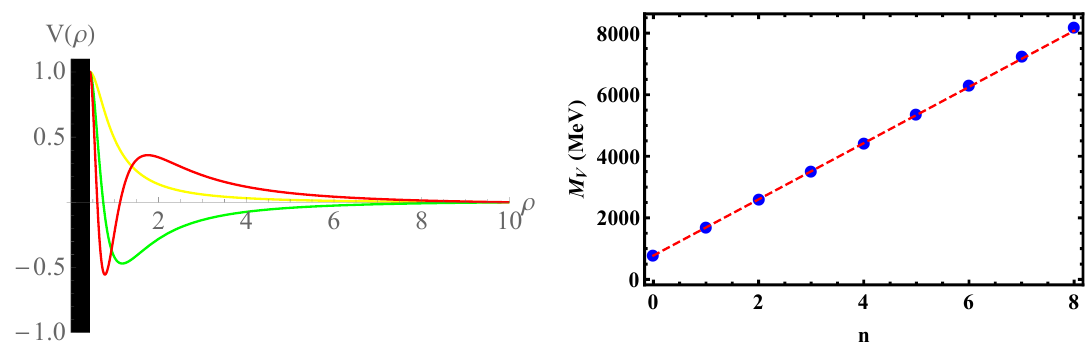
- 1.0 Figure 3. On the left, we show the normalizable solutions to the equations of motion for the vector meson (the black rectangle covers the region below the IR cut off). They are obtained for M V = 1 . 337(775 MeV ) , 2 . 895(1677 . 9 MeV ) , 4 . 45(2578 . 9 MeV ) . On the right we show the numerical masses — blue dots — and the spectral curve that we obtained by fitting to the first six states and verified against the next three. Here, n is the number of nodes of the